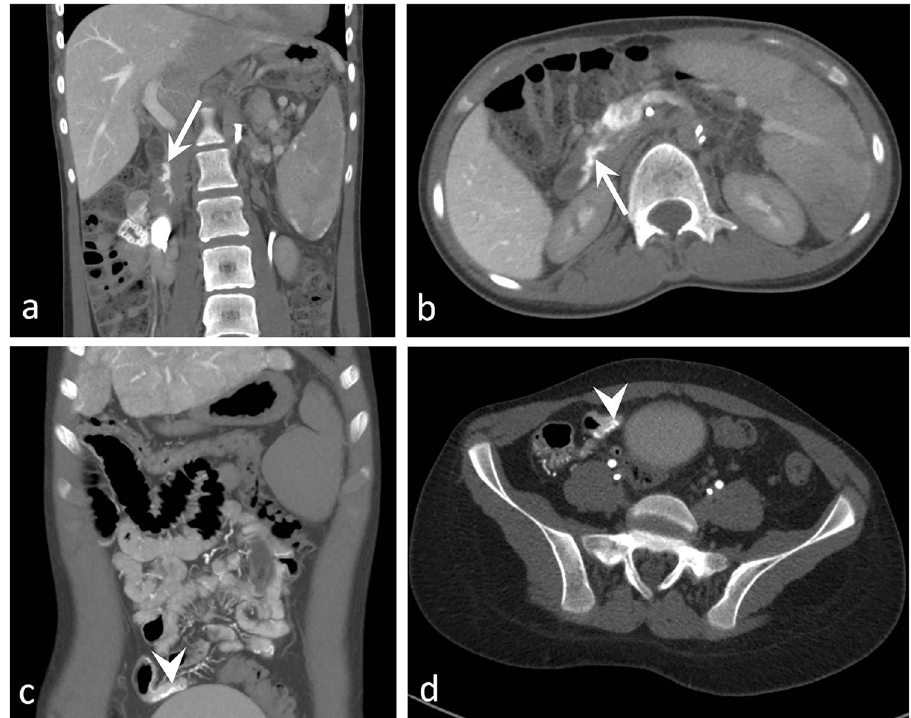
Figure 4. Axial and coronal images of CT-AP of two 16-year-old male patients with congenital hepatic fibrosis ( a , b ) and hepatoportal sclerosis ( c , d ). CT-AP detected small duodenal varices not described in UEG (arrow) and small intestinal varices (arrowheads) not detectable in